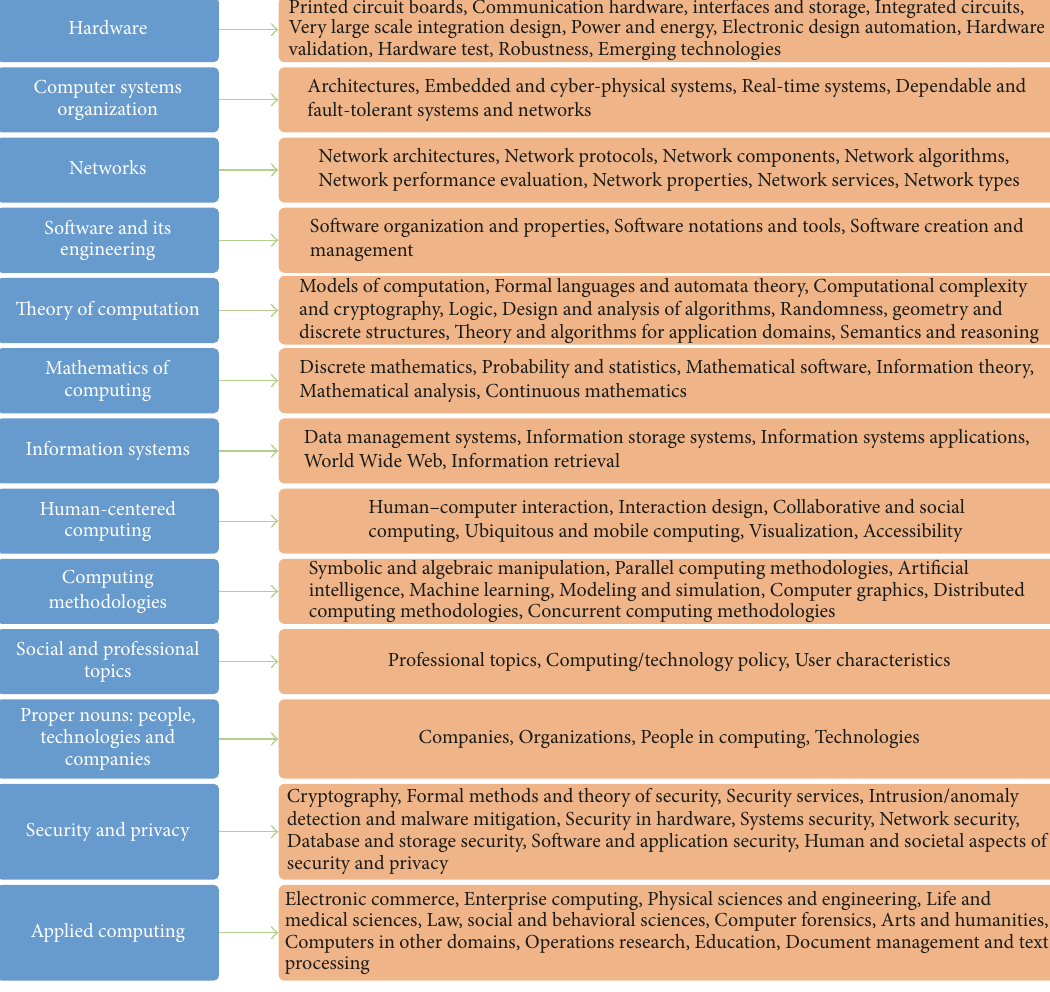
Figure 4: The ACM Computing Classification